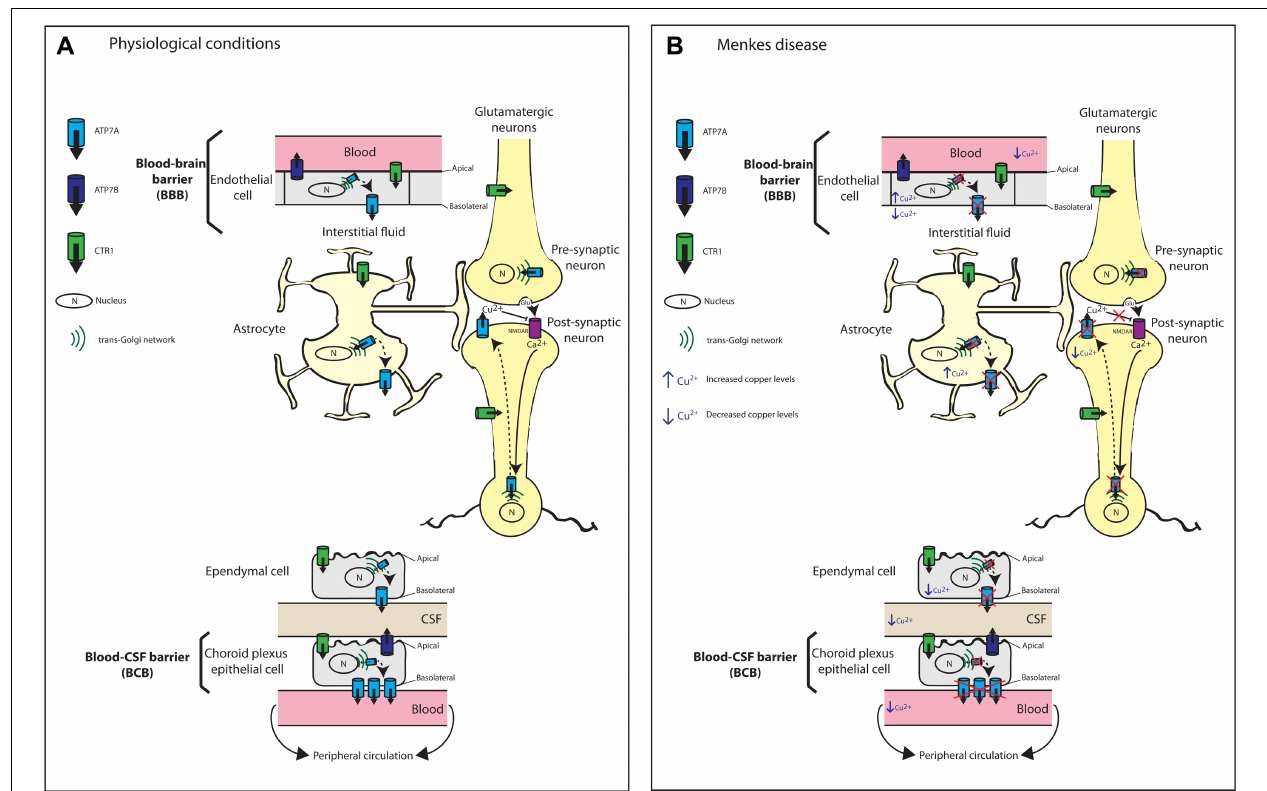
encounter metal ions that cross the BBB and play an important role in copper transport from the blood and CSF toward neurons. Copper transport in glutamatergic neurons is depicted. Copper-independent and reversible trafficking of ATP7A is stimulated by N -methyl- D -aspartate receptor (NMDAR) activation that leads to Ca 2 + influx and is associated with the rapid release of copper from neurons.The released copper down-regulates NMDAR release from glutamatergic neurons, which down-regulates NMDAR activity, can contribute to seizures and neuronal degeneration in Menkes